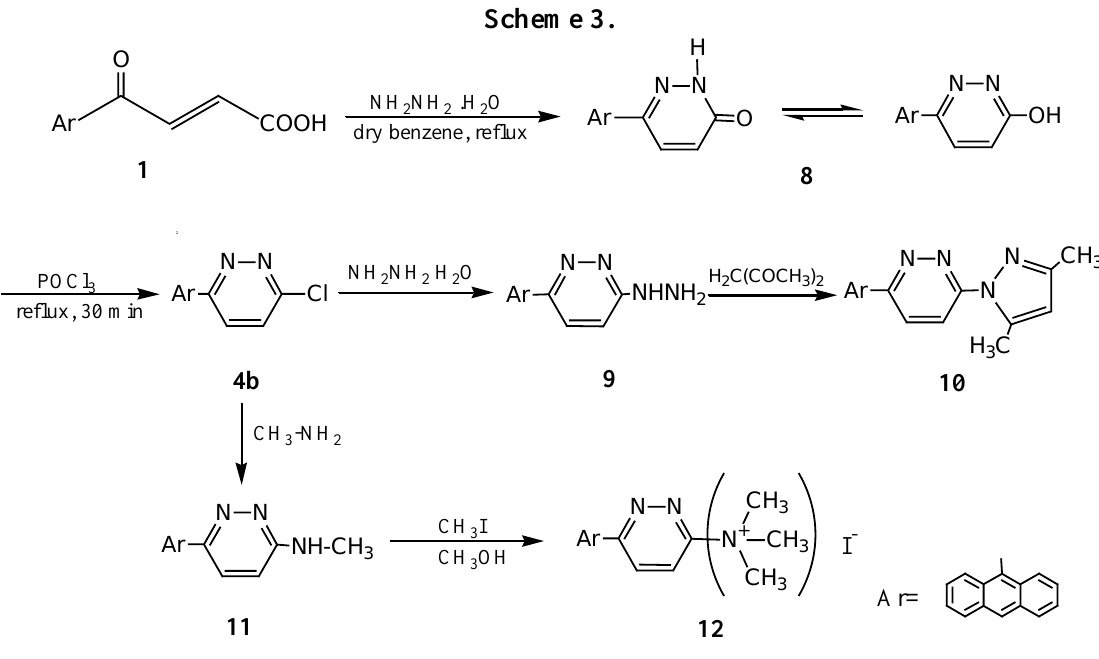
Table 3. Physical properties, mass spectral data and elemental analyses for compounds 8-12.